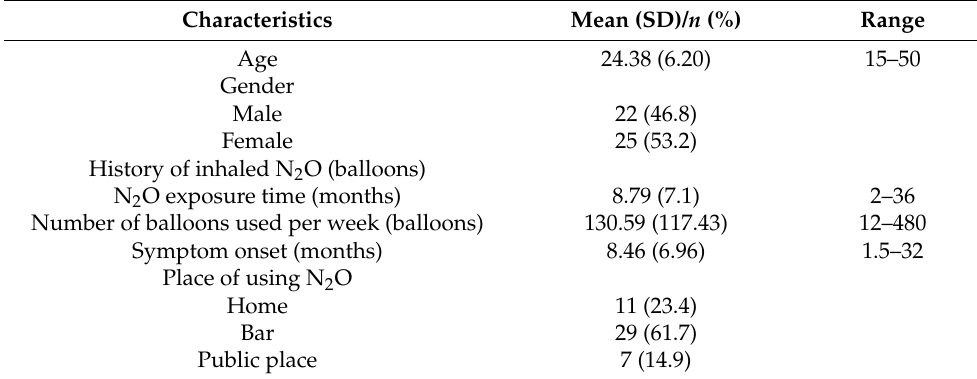
Table 1. Demographic of the patients, nitrous oxide abuse and amounts used ( n = 47).